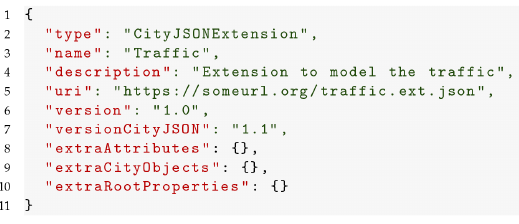
Figure 1. A basic CityJSON Extension schema.